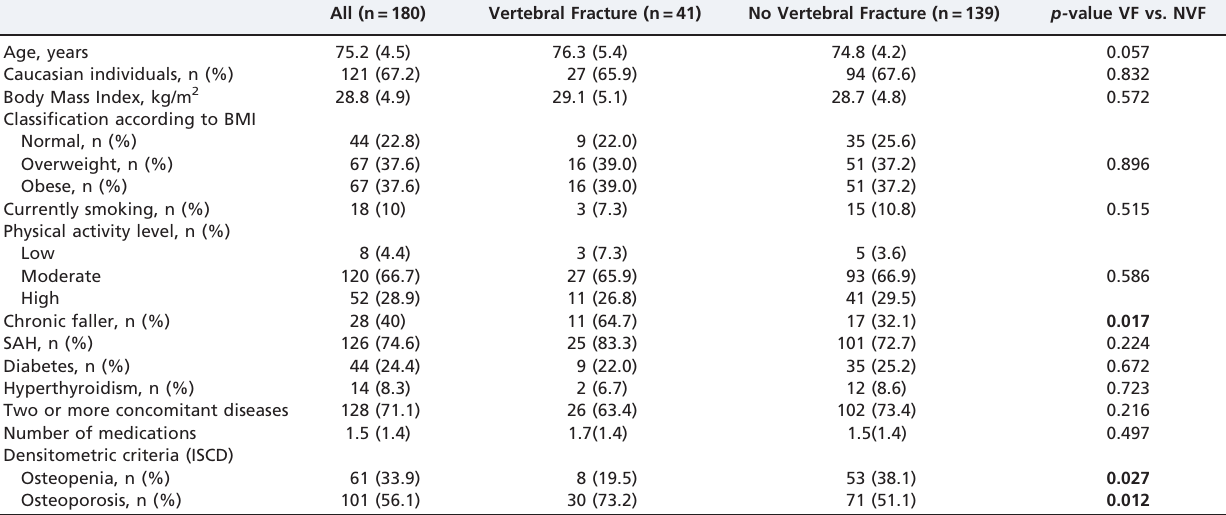
Table 1 - Demographic, anthropometric, and clinical data of the Vertebral Fracture (VF) and No Vertebral Fracture (NVF)